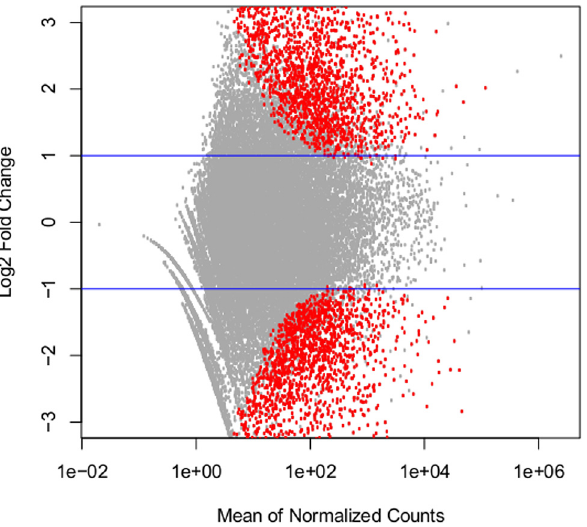
Fig 2. Fold enrichment of significant gene ontology terms. Fold enrichment of significantly enriched (padj < .05) biological process GO terms.